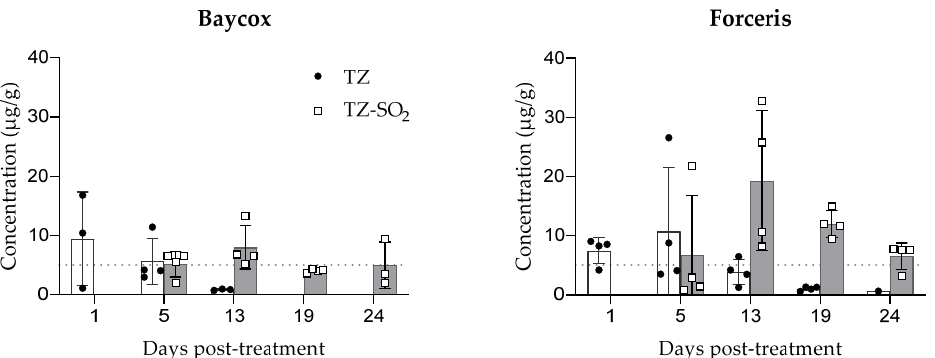
Figure 4. Concentrations of toltrazuril and toltrazuril sulfone (mean ± SD) in the intestinal content following single oral (Baycox 5%) or intramuscular (Forceris) administration to piglets.